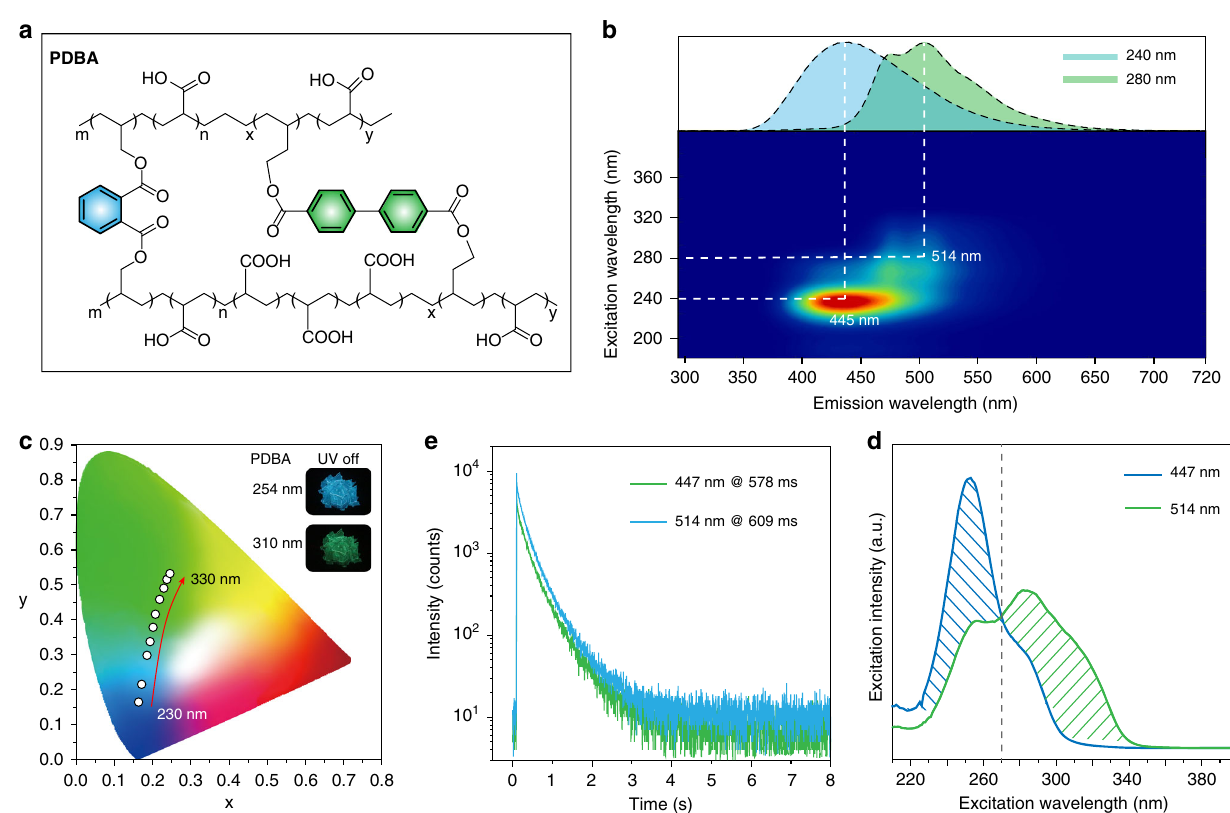
Fig. 4 Molecular structure and phosphorescence properties of the multicomponent copolymer PDBA under ambient conditions. a Molecular structure of polymer PDBA. b Excitation – phosphorescence mapping of PDBA fi lm. The inset image shows the phosphorescence spectra of PDBA excited by corresponding excitation wavelengths. c CIE chromaticity diagram for polymer PDBA with excitation varied from 230 to 330 nm. Inset: UOP photographs of polymer fi lm PDBA excited at 254 and 310 nm after switching off the UV light, respectively. d Lifetime decay curves of bands at 447 and 514 nm in polymer PDBA, respectively. e Phosphorescence excitation spectra of polymer PDBA at 447 and 514 nm.